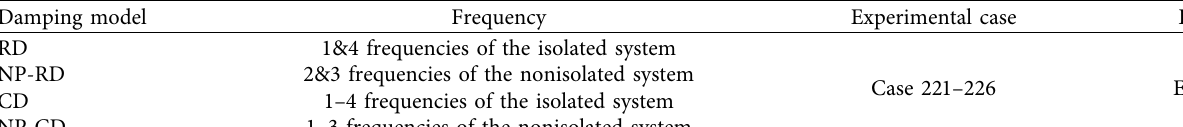
Figure 13: Calculation errors of isolation displacement by using different damping models (PGA � 0.07g): (a) case 207, (b) case 208, (c) case 209, (d) case 210, (e) case 211, and (f) case 212. Table 10: Calculation schedule with PGA � 0.2g.